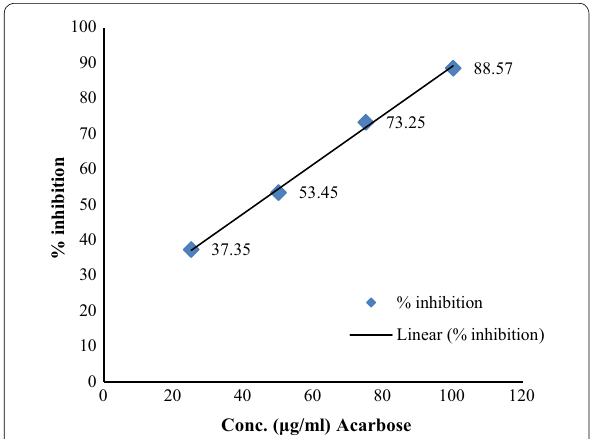
Fig. 2 Standard graph of acarbose